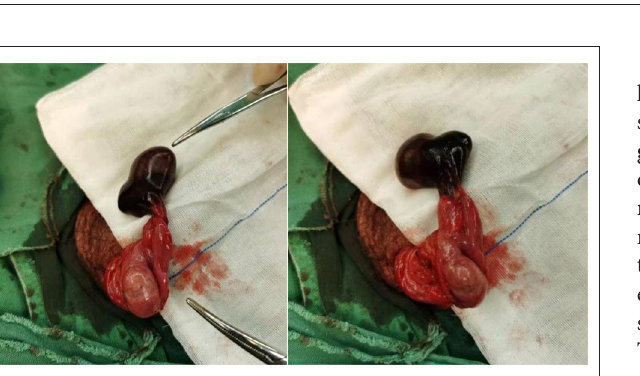
FIGURE 1 | Color Doppler image: Two testicles were lying in the left hemi-scrotum. The lower testicle (A) is smaller than the higher testicle (C) and has normal blood flow (B) . There is no visible vascular flow in the higher testicle (D) .